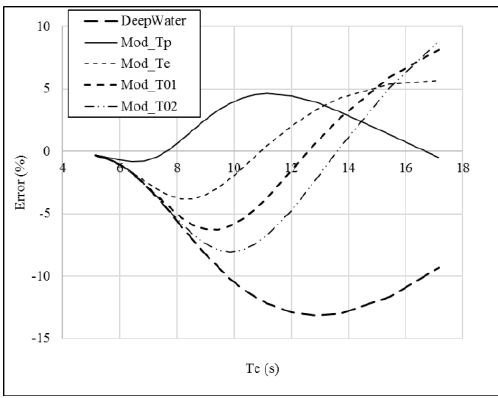
Figure 6. Modifications of the wave energy assessments using different characteristic periods ( h = 50 m).